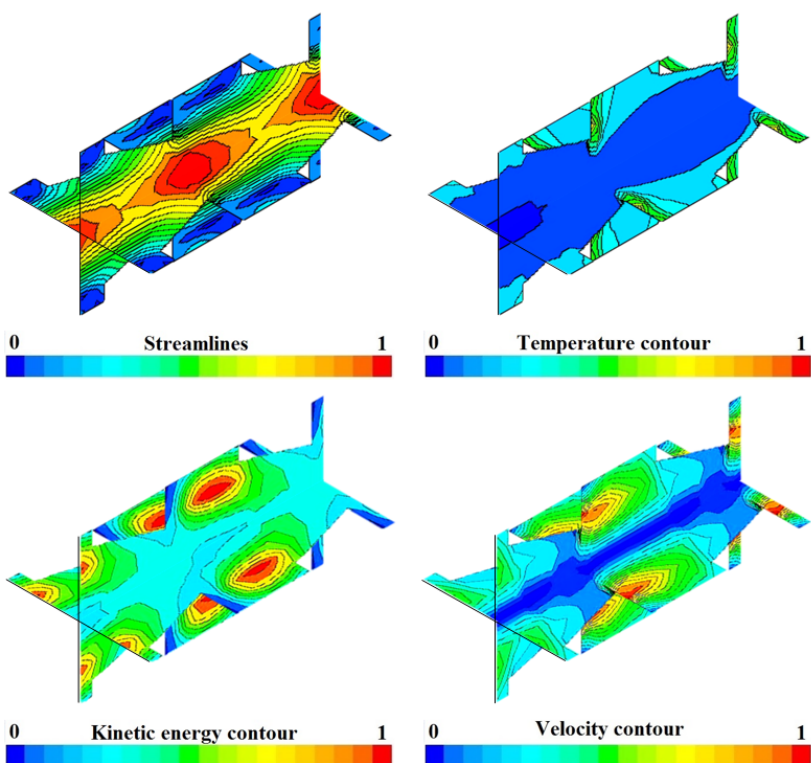
Figure 24. Streamlines, temperature, kinetic energy and velocity magnitude contours for Case D with R = 15 mm, D 1 = 12 mm, and D 2 = 24 mm parameters at Re = 15,000, and ϕ = 0.5%.